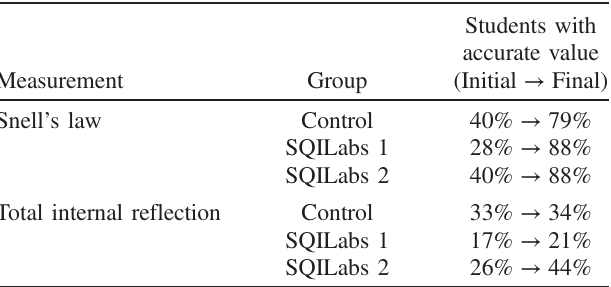
TABLE II. Percentage of students in each group with accurate Snell ’ s law and total internal reflection measurements initially and after any changes